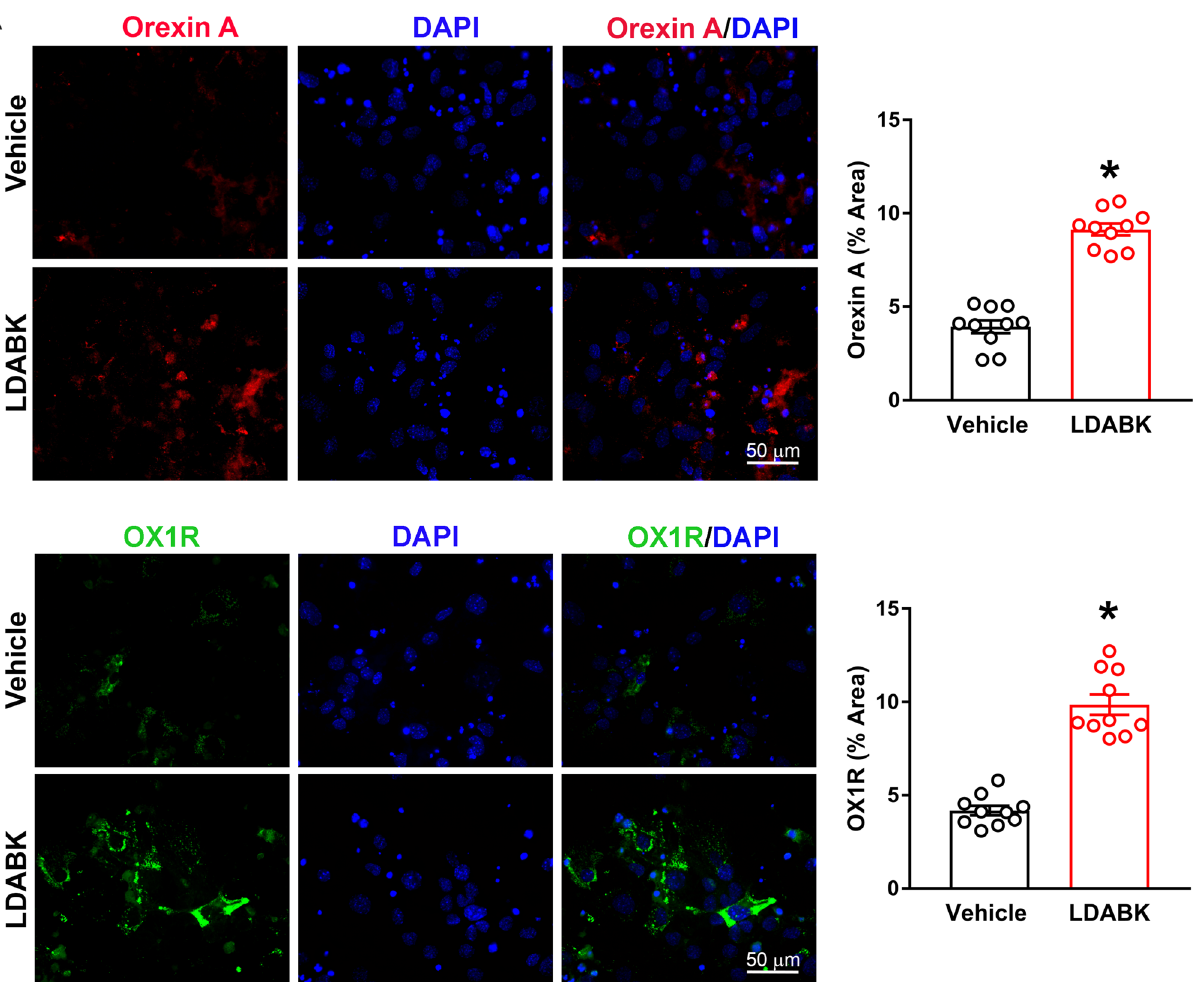
Figure 5. LDABK-mediated orexin A and orexin 1 receptor (OX1R) upregulation in primary hypothalamic neurons. Immunofluorescence staining and corresponding quantification data revealed that primary hypothalamic neurons stimulated with Lys-des-Arg-BK 9 , (LDABK, 300 nM) for 24 h showed an increase in orexin A ( A ) and OX1R ( B ) expression, indicating B1R activation leads to an upregulation in orexin system signaling. Statistical significance: Two-tailed t test. * p < 0.05 versus Vehicle; n = 10